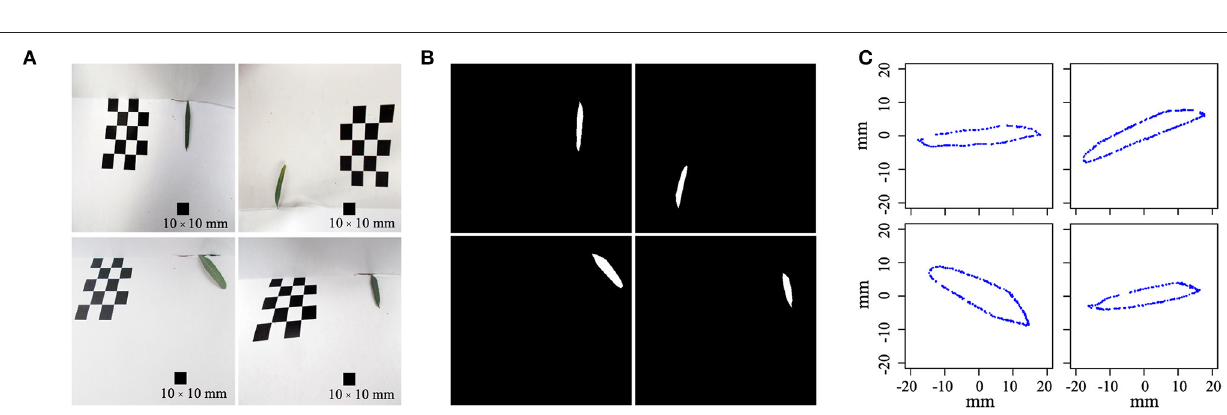
FIGURE 1 | Leaf shape tracking strategy. T1–T6 indicate the time points with an equal time interval. At T1, leaves from the lower, middle, and upper part of the tree were selected for photographic tracking. At T2–T6, newly formed leaves from the upper part of the tree were selected for additional photographic tracking.